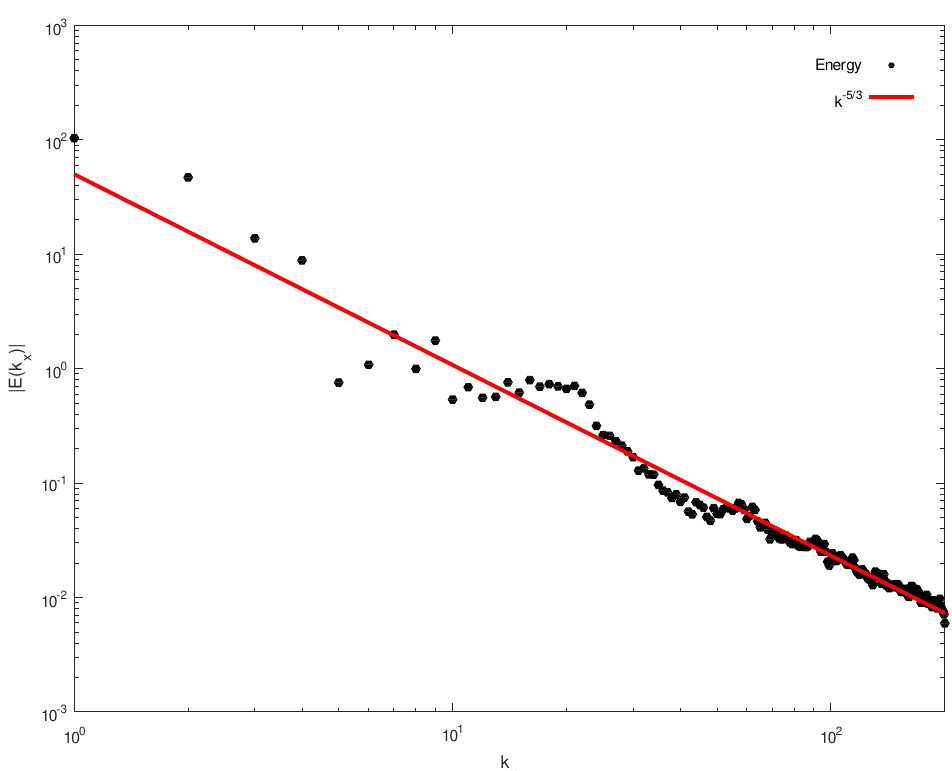
Figure 7. The kinetic energy spectrum of the cyclostrophic flow. The straight line, corresponding to k − 5/3 slope, is provided for reference.